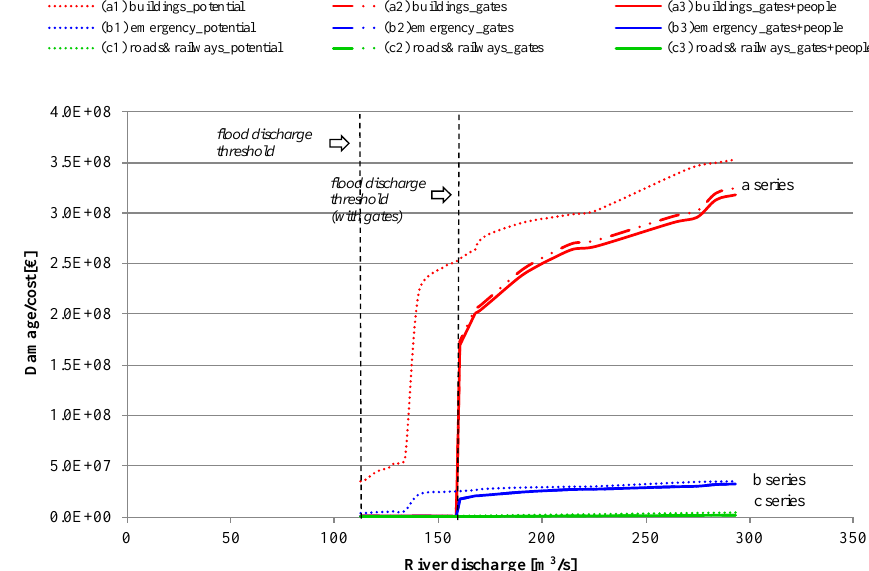
Fig. 6. Potential damage and emergency costs if preventive measures are implemented or not implemented. The figure distinguishes among different classes (referred to as a, b, c; to be noted is that “a” includes damage to both buildings structure and contents) and between the effect of bridge gates only and the joint effect of bridge gates and people’s actions (referred to as 2 and 3).